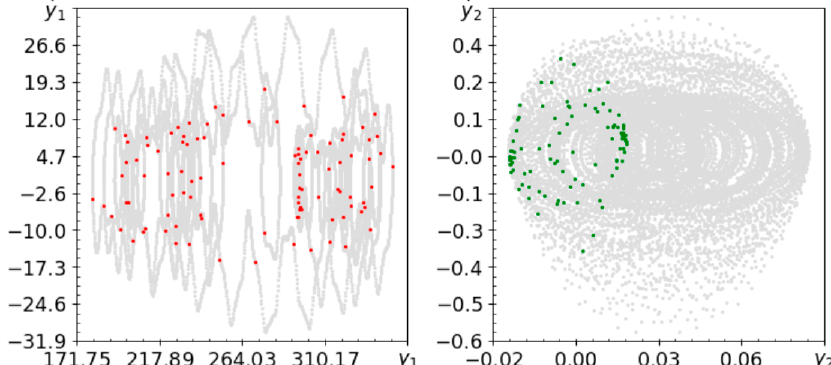
Figure 6. Phase planes (gray lines) and Poincaré maps (red and green dots) for A = 0.1, ω = 4.94.